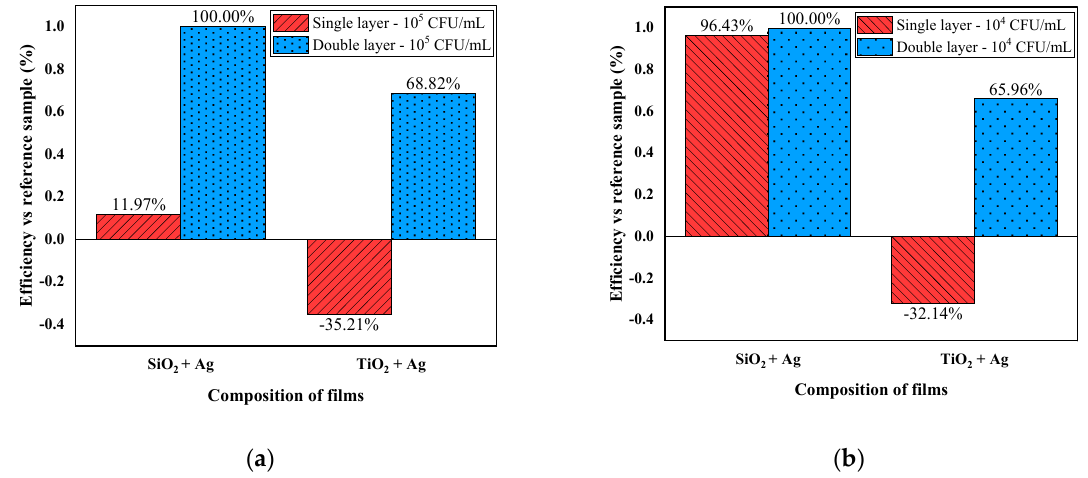
Figure 6. Antibacterial efficacy of films for concentrations other than Escherichia coli -10 5 CFU/mL ( a ) and 10 4 CFU/mL ( b )-for single-layer experiments and double-layer tests (sandwich). Notably, Ag particles’ adhesion to cell membranes and consequent lipid bilayer changes result in enhanced membrane permeability, damage and cell death, a power- ful antibacterial action that appears to be more pronounced when smaller nanoparticles are utilized